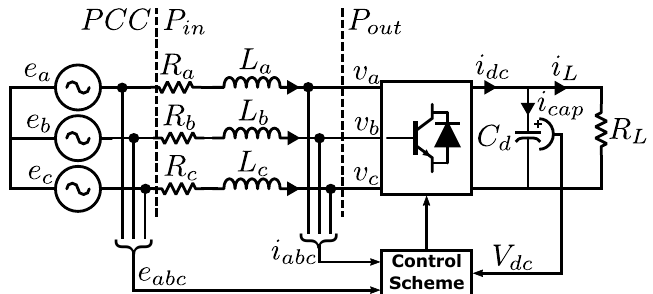
Figure 23. Schematic diagram of the power quality improvement scheme. The proposed control scheme regulates the instantaneous active power at the input ( e abc ) and output ( V dc ) of the converter to minimize the